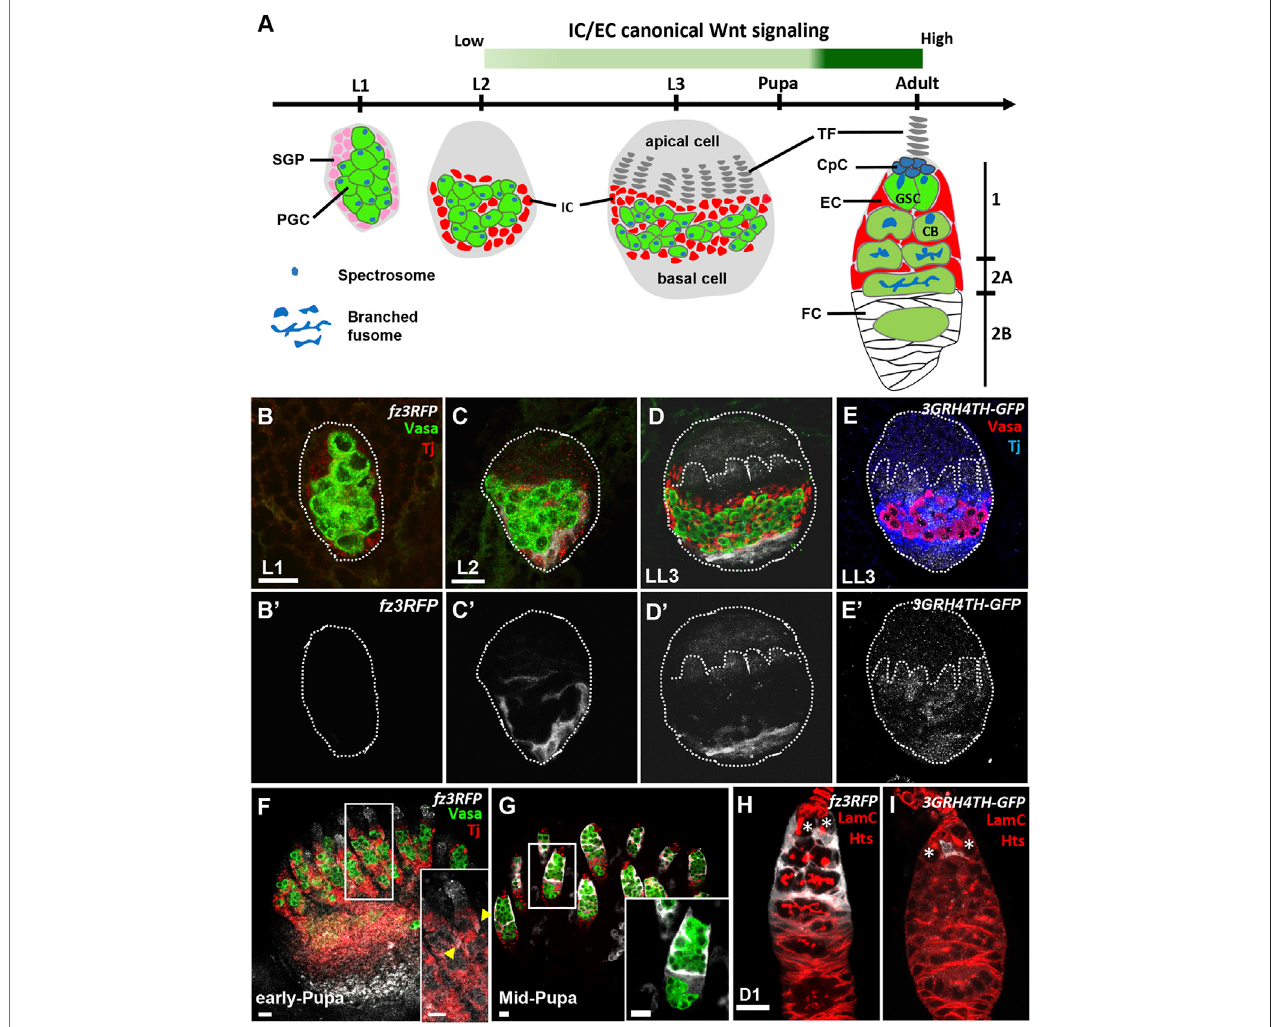
FIGURE 1 | Canonical Wnt signaling is activated in the somatic cells of developing ovaries. (A) Schematic of Drosophila larval gonads and the adult germarium. Primordial germ cells (PGCs), each with a round-shaped fusome (unique membrane-enriched organelle), and somatic gonad precursors (SGPs) are present at the L1 and L2stages. PGCandSGPnumbersaregreatlyincreasedattheL3stage,andSGPsdifferentiateintoapicalcells,terminal fi laments(TFs), intermingledcells(ICs)and basalcells.ICslaterfurtherdifferentiateintocapcells(CpCs),escortcells(ECs),andprobablyfolliclecells(FCs).Duringthepupalstage,apicalcellsmigratethrough TFs, ICsandbasalcellstogenerate ovarioles;theanteriorstructureoftheovarioleisthegermarium.Intheadultgermarium,GSCsand theirprogenyarewrappedbyEC protrusionsinregions1and2A.Then,ECsarereplacedbyfolliclecells(FCs)inthe2Bregion.DuringthegrowthofGSCprogeny,fusomesbecomebranched.Thegreen bar indicates canonical Wnt signaling is detectable in the EC precursors of LL3 animals, and it becomes strongly activated in ECs at the mid-pupa stage, persisting into the adult fl y. (B – I) L1 (B) , L2 (C) and late-L3 gonads (D and E) with fz3RFP in B-D (gray, canonical Wnt signaling reporter), 3GRH4TH-GFP in E (gray, canonical Wnt signaling reporter), Vasa (green in B – D, red in E, PGCs) and Tj (red in B-D, blue in E, ICs). (B ’– D ’ ) and E only show fz3RFP and 3GRH4TH-GFP channel, respectively. Dashed circles outline the gonad; dashed line marks a forming TF. (F – I) Early-pupa (F) , Mid-pupa (G) and adult day 1 germaria (H and I) with fz3RFP in F-H (gray, canonical Wnt signaling reporter), 3GRH4TH-GFP in I (gray, canonical Wnt signaling reporter), Vasa (green in F and G, germ cells), Tj (red in F and G, EC and follicle cell nuclei), LamC (red in H and I, TF and cap cell nuclear envelopes), and Hts (red in H and I, fusomes). Insets in F and G show enlarged images from the corresponding dashed squares in F and G. Arrowheads in F inset show ECs with fz3RFP . The genotype in F is nos > gfp RNAi . Asterisks in H and I mark GSCs. Scale bars are 10 μ m.